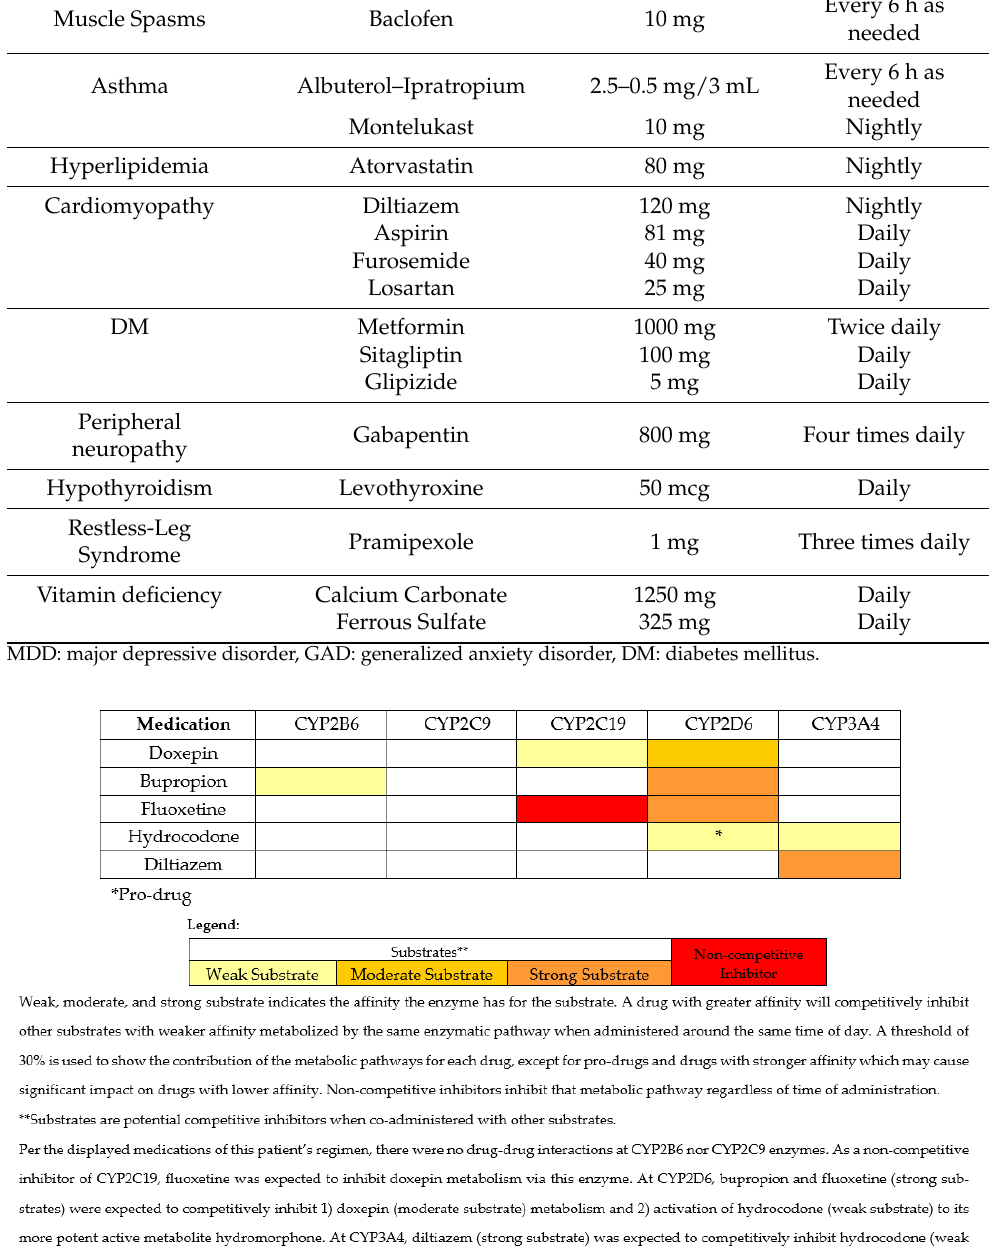
Table 1. Medications at the time of the fall.